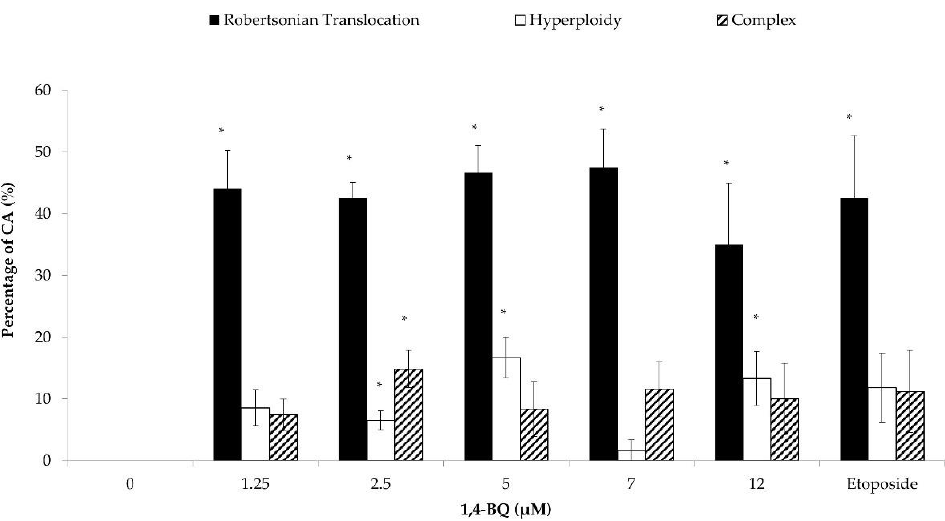
Figure 6. Effect of 1,4-BQ on different types of CA (Rb, hyperploidy, and complex) in myeloid progenitor cells harvested after 14 days of CFU assay following pre-exposure of MBMCs to 1,4-BQ for 24 h. Twenty metaphases were scored for each experimental group and the percentage of each type of CA is as presented. Data are presented as the mean ± S.E.M. ( n = 3) and analyzed by using one-way ANOVA. * p < 0.05 compared with the negative control group.